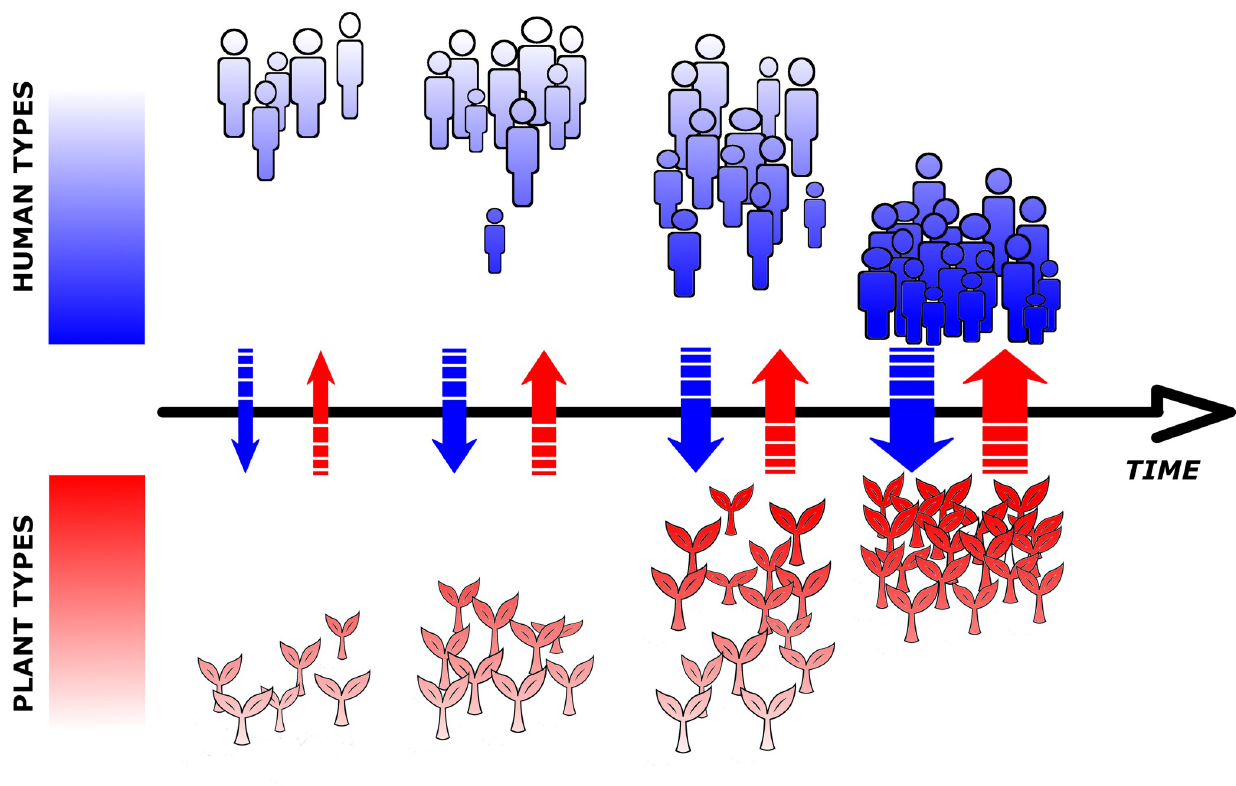
Fig 2. A successful case of coupled mutualism and coevolution, as defined in the Human-Plant Coevolution model. As the interaction between populations (coloured arrows) becomes stronger, carrying capacities increase and populations grow (number of organisms) and stronger mutualism types (stronger colour shades) become more